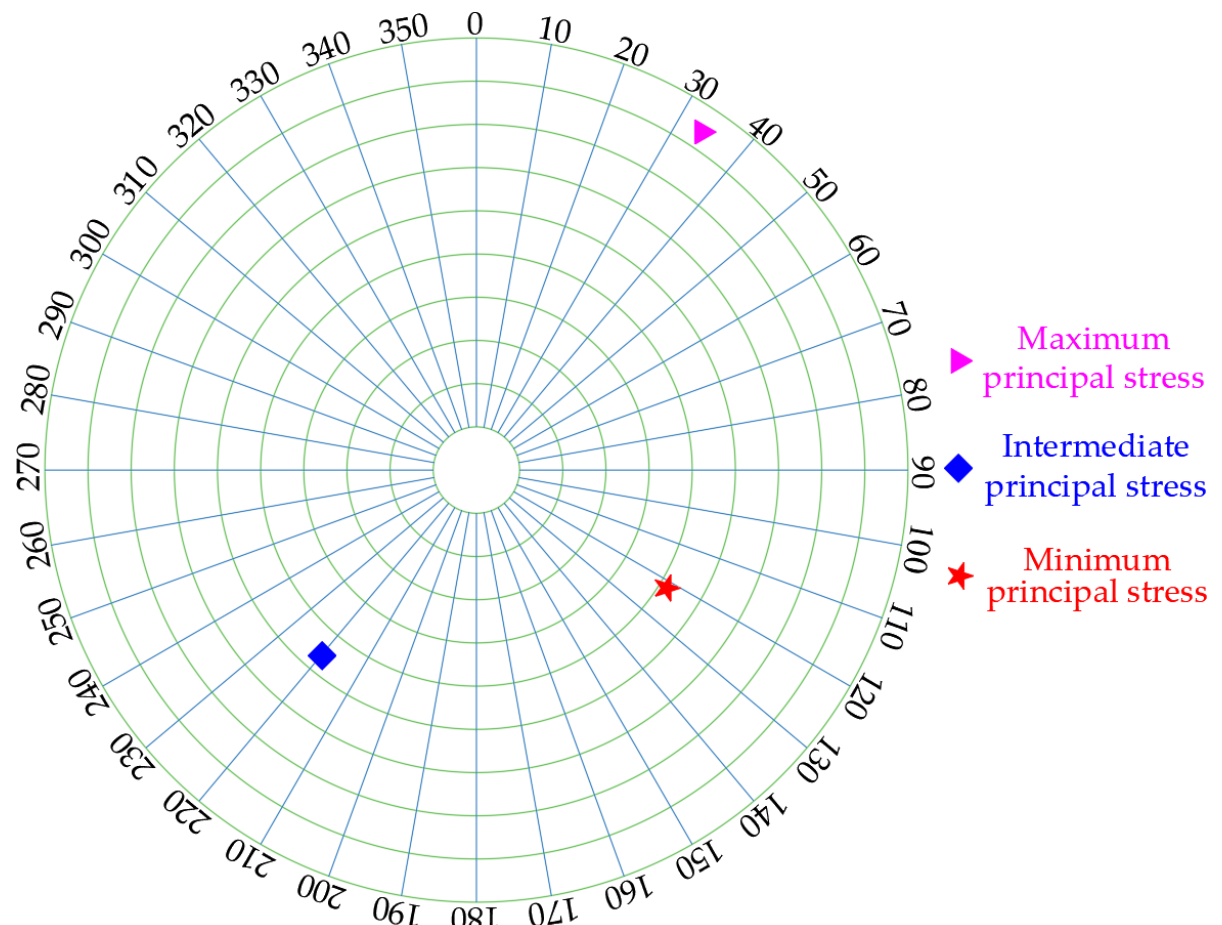
Figure 6. In situ stress test results.